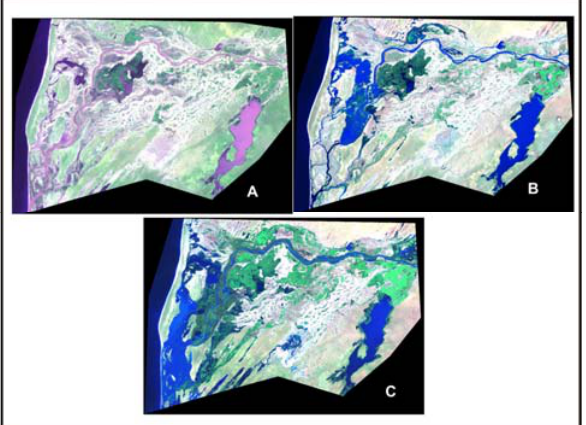
Figure 3 : Classified Landsat MSS, TM, ETM+ images of 1979 shown in (A), 1987 in (B) and 1999 in (C).